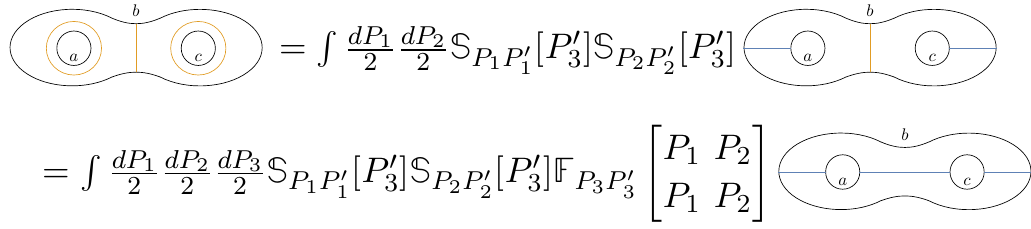
Figure 8 . The sequence of moves expressing a boundary dumbbell channel block (top left) in terms of boundary sunset channel blocks (bottom right) for the decomposition of the partition function of the sphere with three